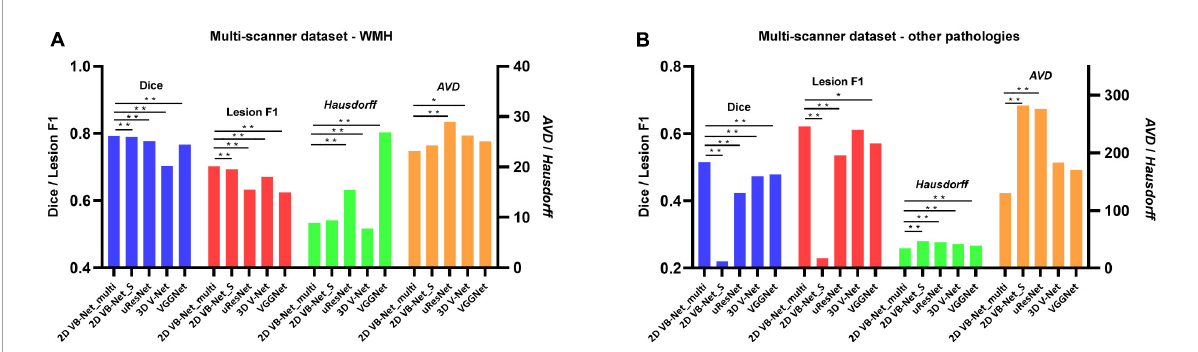
FIGURE3 Performance differences among the algorithms on the multi-scanner dataset. (A) Differences in the performance of WMH segmentation among the five methods; (B) Differences in the segmentation performance of other intracranial pathologies among the five methods. The performance of each algorithm was measured by Dice, lesion F1, Hausdorff, and AVD , respectively. Of note, the 2D VB Net_multi, uResNet, 3D V-Net, and VGGNet were trained and evaluated based on multi-modality MR images (T1-weighted, T2-weighted, and FLAIR), whereas the 2D VB Net_S was trained and evaluated based on only FLAIR images. A lower value of Hausdorff and AVD indicates better performance of the algorithm. *, ** P -value of two-tailed paired t -test between the performance of the 2D VB-Net _multi and the other algorithms; *, P < 0.05 significance level; **, P < 0.001 significance